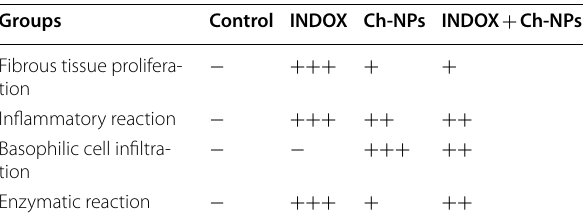
Table 5 The modulatory effect of Ch-NPs on lung tissue in the study groups Groups